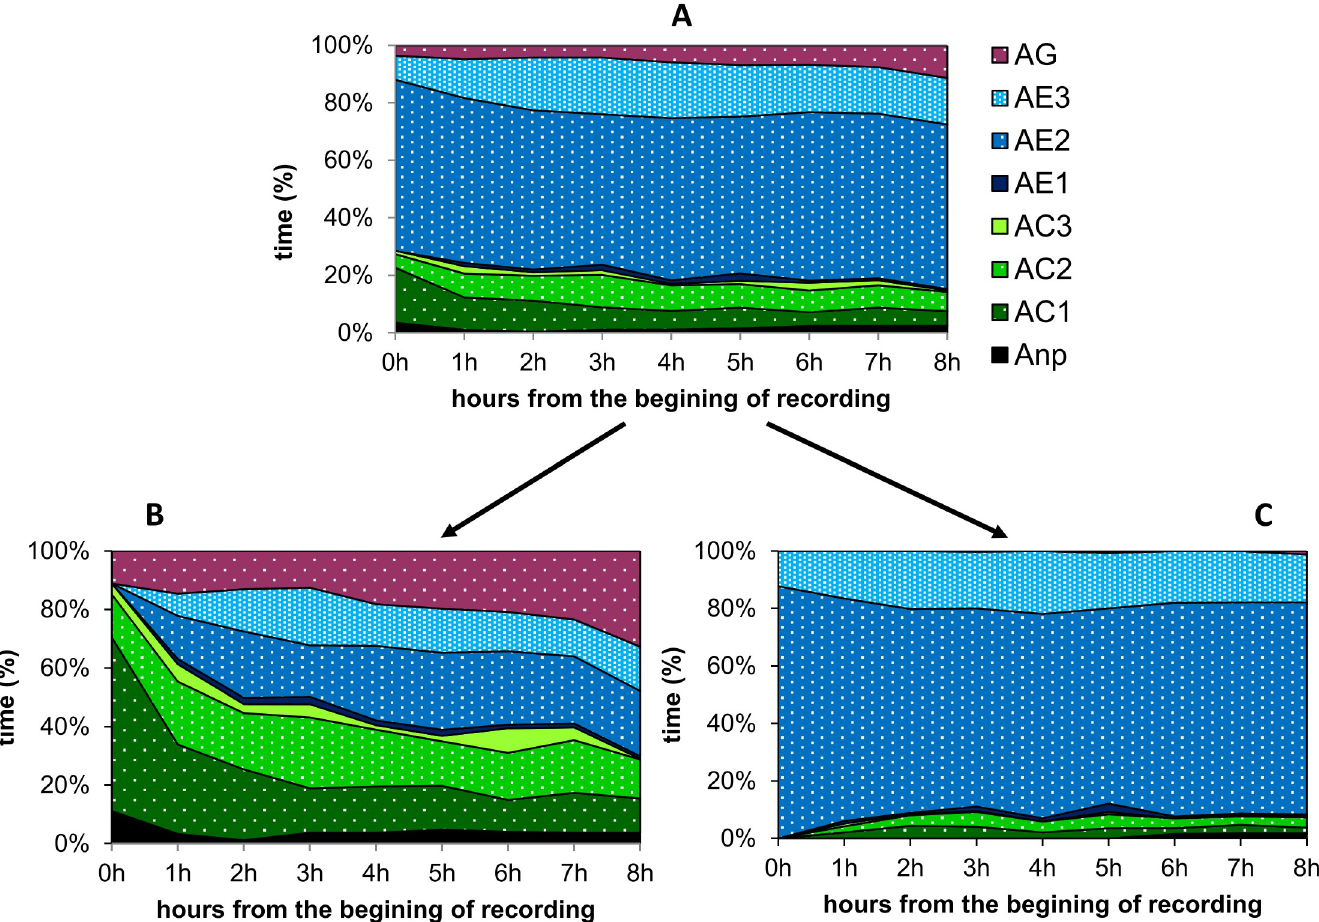
Fig 8. Sequential changes in the probing behavior of Adelges laricis on Larix decidua . The graphs represent the proportion of time devoted to a given activity at the end of each hour of the 8-hour continuous EPG monitoring. (A) Image based on all replications (n = 84). (B) Image based on recordings that started with either any of AC or AG waveform patterns (n = 24). (C) Image based on recordings that started with any of AE waveform patterns (n = 57). Anp–non-probing. AC1, AC2, AC3 – variants of pathway phase AC. AE1, AE2, AE3 –variants of phloem phase AE. AG–xylem phase. https://doi.org/10.1371/journal.pone.0251663.g008 PLOS ONE | https://doi.org/10.1371/journal.pone.0251663 May 18,